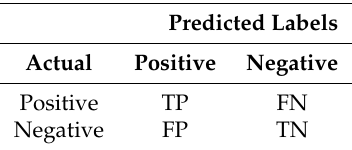
Table 5. The confusion matrix